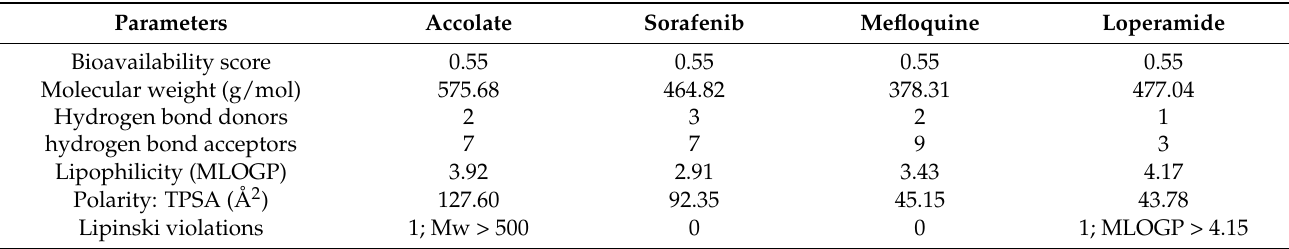
Table 2. Physicochemical parameters for the drugs.